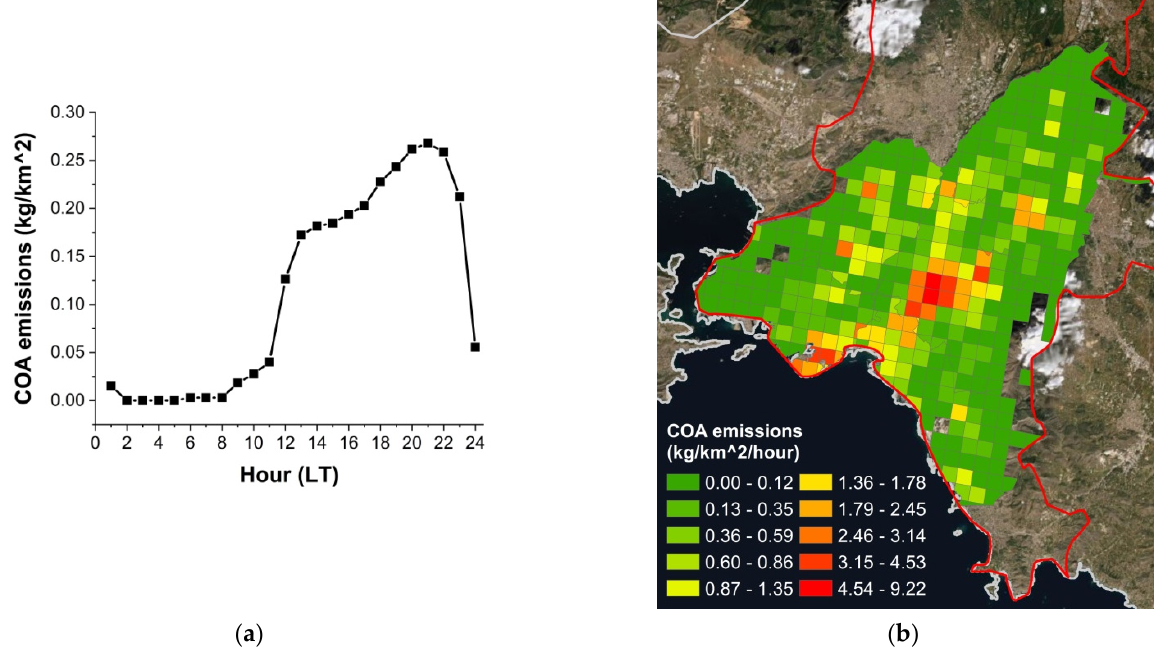
Figure 8. ( a ) The diurnal profile of COA gridded emissions (in kg/km 2 , for a Friday in January) for a selected cell in Central Athens and ( b ) the spatial distribution of COA emissions in January at 21:00 LT. Table 9. Annual emissions produced by the grilled meat at the GAA.